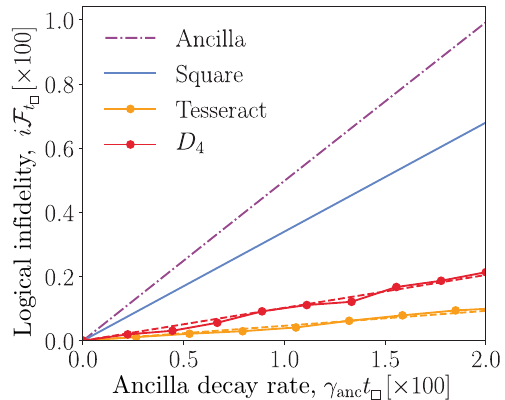
FIG. 9. Logical process infidelity, i F , in the presence of qubit ancilla decay, γ anc . The infidelity is computed for a time t (cid:2) , i.e., the time required to perform a controlled translation C ˆ T ( s ) in the single-mode square code. The dotted-dashed purple line corre- sponds to the infidelity of the bare ancilla. Dots are the results of simulations, and dashed lines are linear fits. Although the infi- delity of all GKP codes is proportional to the decay rate of the ancilla, multimode codes are much more robust to ancilla